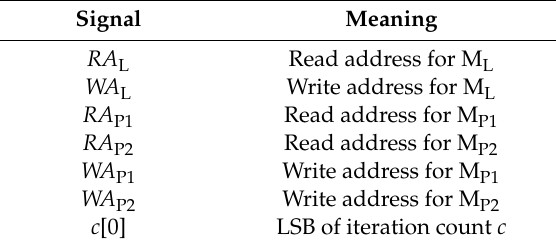
Table 1. List of signals.